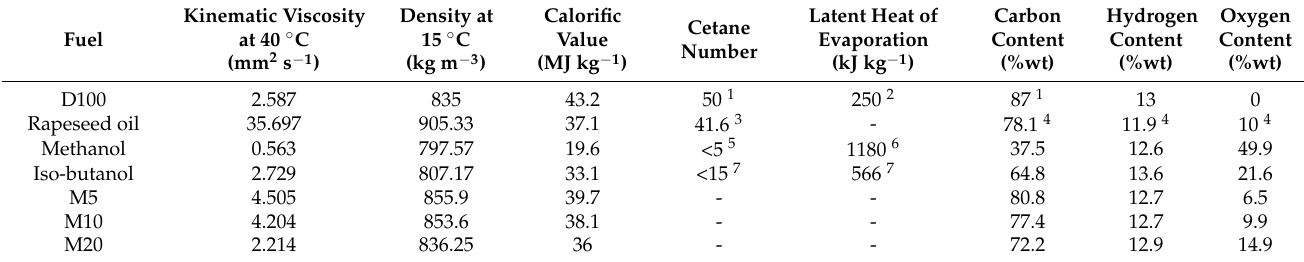
Table 1. Test fuel specifications and their